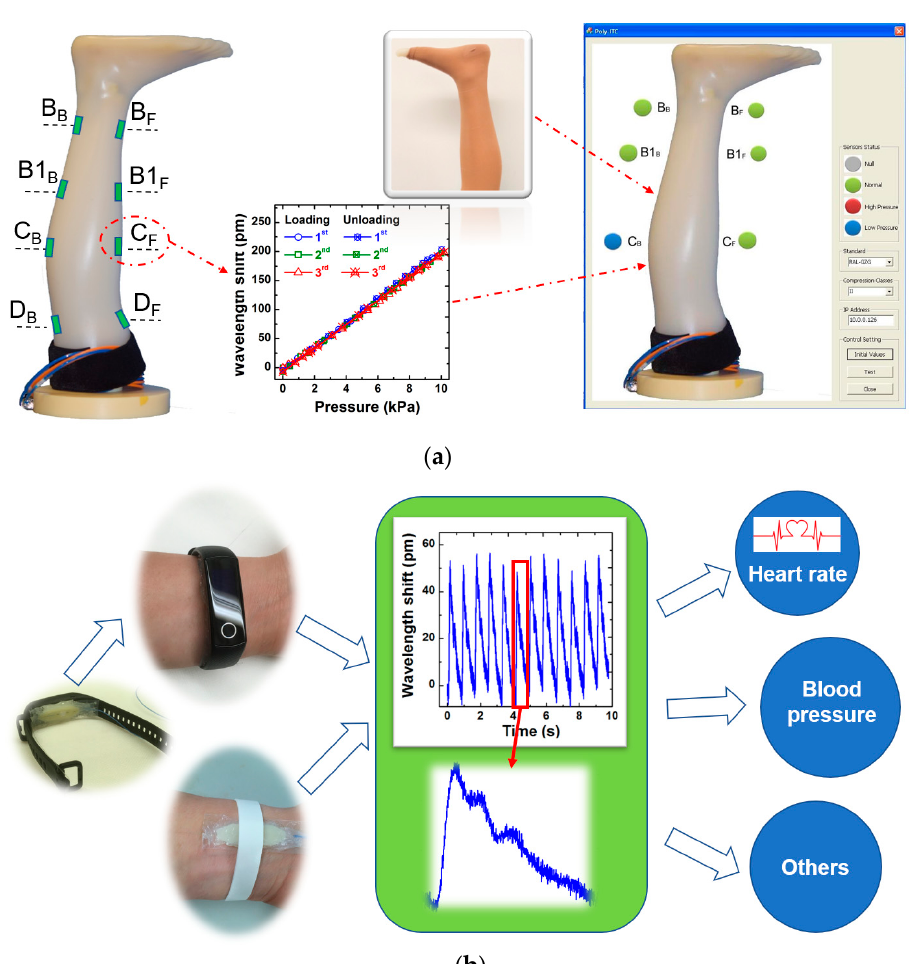
Figure 6. ( a ) Photo of a fabricated leg mannequin with optical sensors, which are setup based on the standard (Quality Assurance RAL-GZ 387 / 1), marked by B F ~D F and B B ~D B in the front and back side, respectively; Illustration of the calibration result of one fabricated optical sensor on the system (Figure 3a); Photo of compression stockings put on the fabricated leg mannequin, and a simple user interface for measurement of compression stockings, showing the pressure exerted on leg: green light is normal pressure, red light is high pressure in and blue light is low pressure; ( b ) Illustration of the application of wrist pulse measurement, where the thickness of the film over the frame base decreases to 0.4 mm for enhancing the sensitivity on pressure.